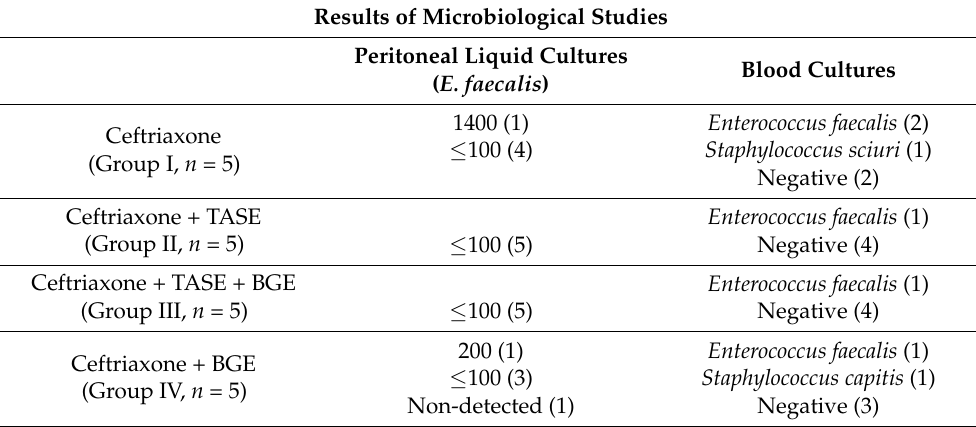
Table 3. Results of blood and peritoneal fluid cultures stratified by treatment groups. Results of Microbiological Studies